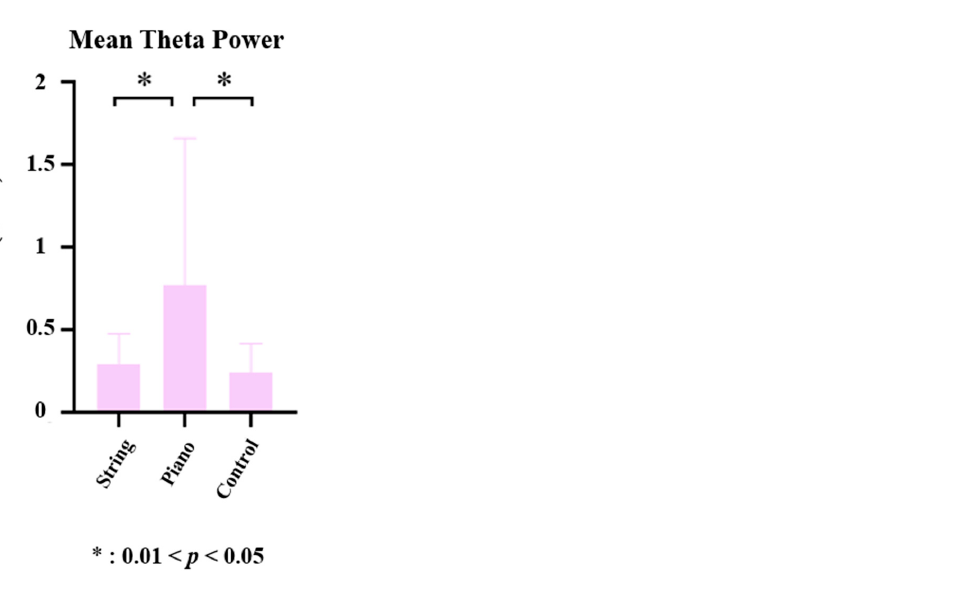
Figure 5. Group mean difference in theta power between three groups (string musicians showed as figure). The measurements reflect the mean theta (4–7 Hz) power between 500 and 800 post-stimulus